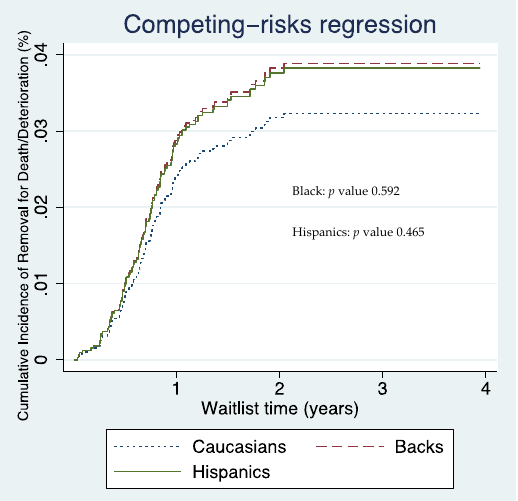
Figure 2. Competing risk regression of Caucasian, Black, and Hispanic patients demonstrating relative removal from the waitlist for death or clinical deterioration. Table 2. Multivariable analysis.